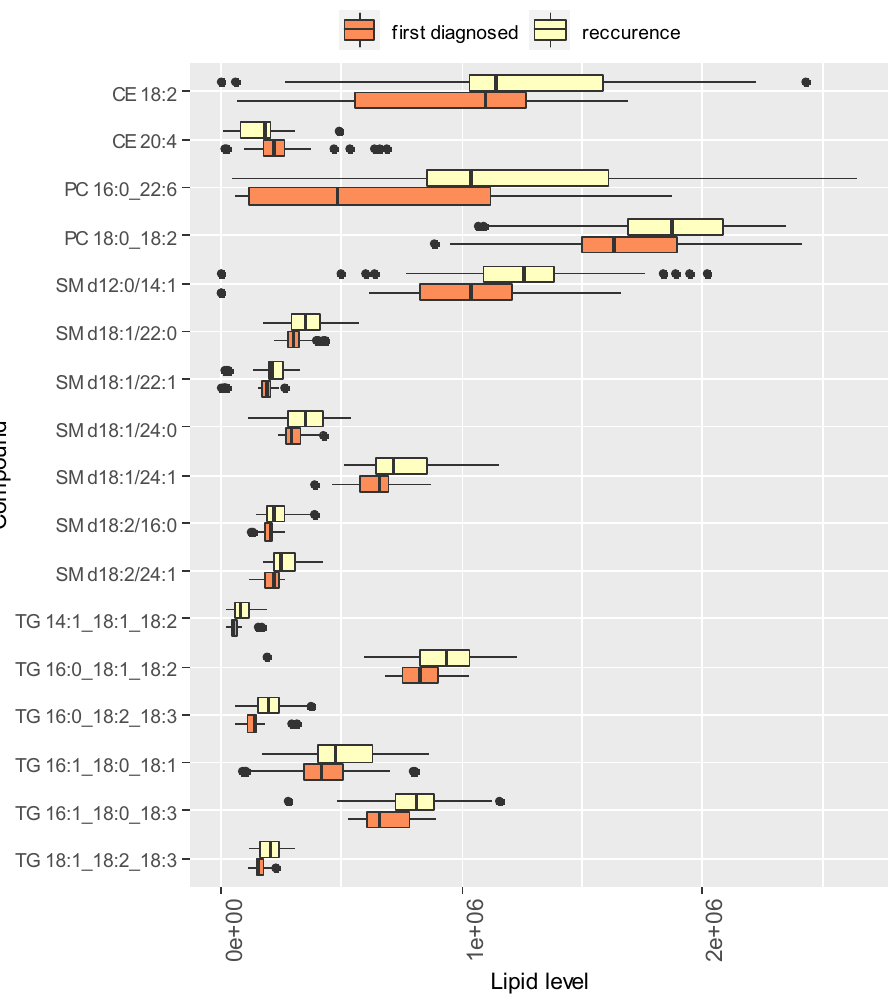
Figure 4. Relative intensity of marker plasma lipids in the OPLS-DA model classifying UF and RUF groups. Orange color corresponds to first-time diagnosed UF, and yellow color corresponds to the RUF. The diagram shows Q1 − 1.5 × IQR, Q1, Me, Q3, Q3 + 1.5 × IQR. Black dots correspond to